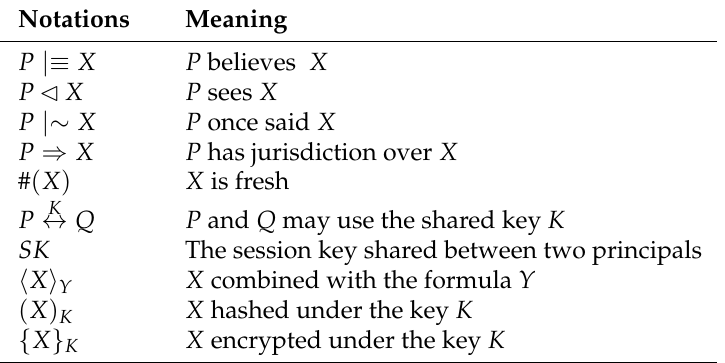
Table 2. BAN logic